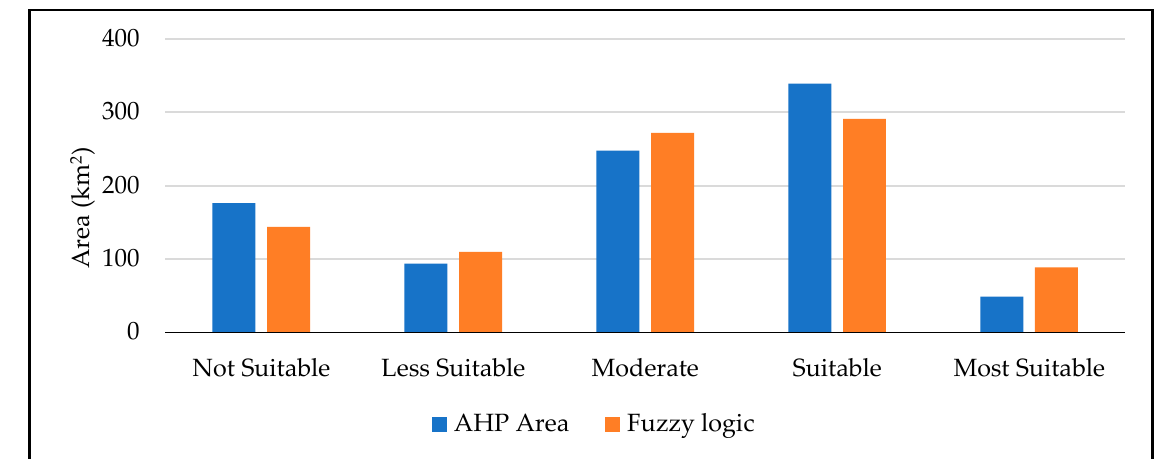
Figure 9. Area of AHP-WLC vs. Fuzzy logic method.